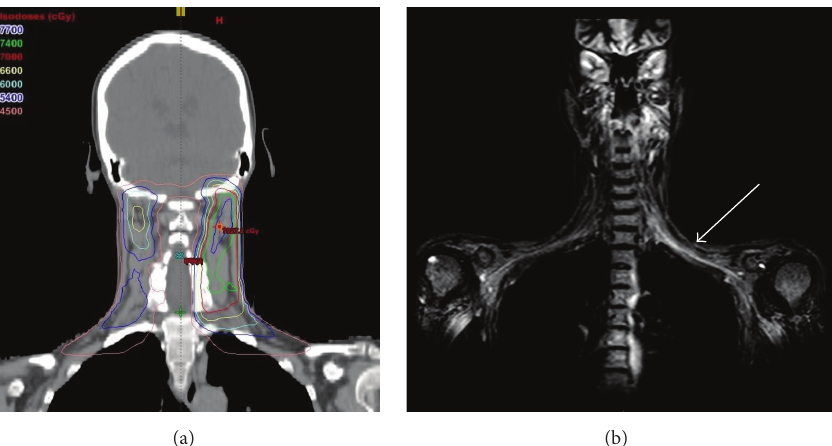
Figure 1: (a) Composite plan with coronal isodose distributions. (b) MRI of the brachial plexus, with T2 prolongation on the left (arrow). Cranial and brachial nerve roots emerge in isodose regions receiving 6600–7400